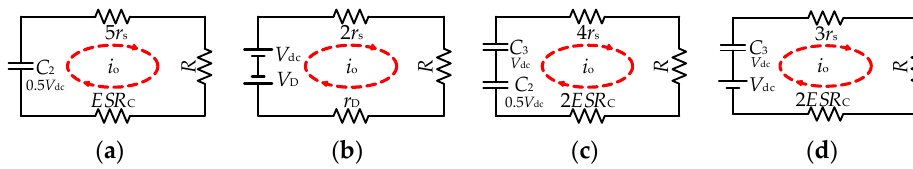
Figure 9. Equivalent circuits of four working modes. ( a ) +0.5 V dc , ( b ) + V dc , ( c ) +1.5 V dc , ( d ) +2 V dc .